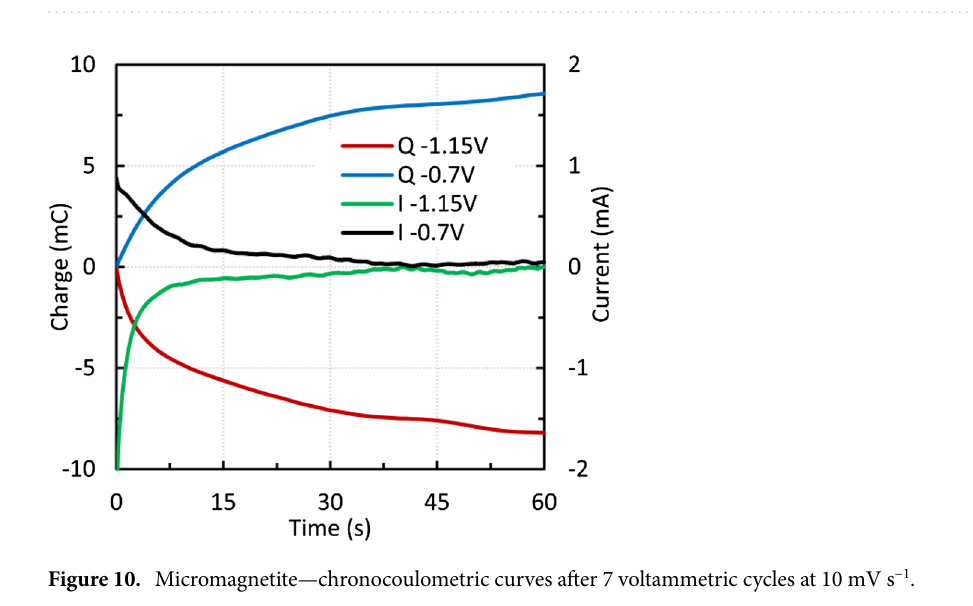
Figure 9. Effect of the scan rate on the anodic and cathodic peak height—the second cycle, micromagnetite- modified CPE.